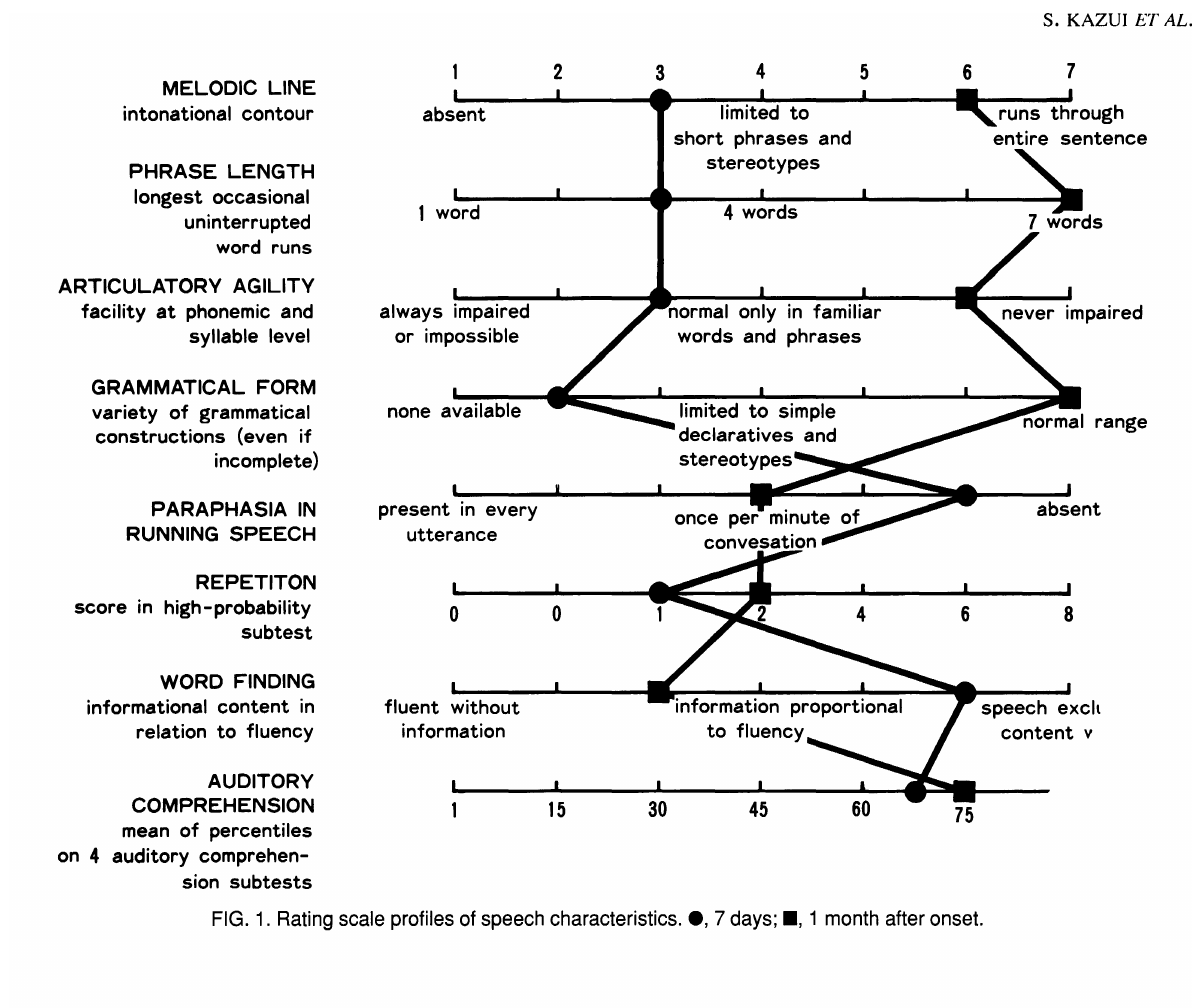
FIG. 1. Rating scale profiles of speech characteristics. e, 7 days; ., 1 month after